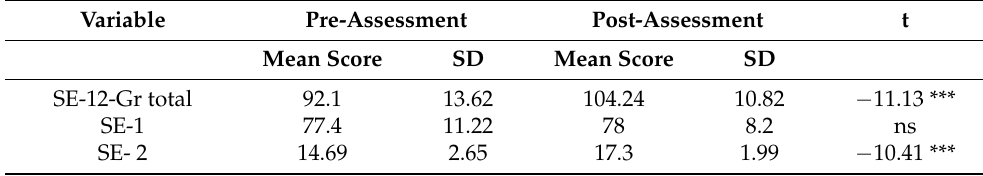
Table 4. Self-Efficacy-12-Gr (SE-12-Gr) in pre- and post-assessments ( n =